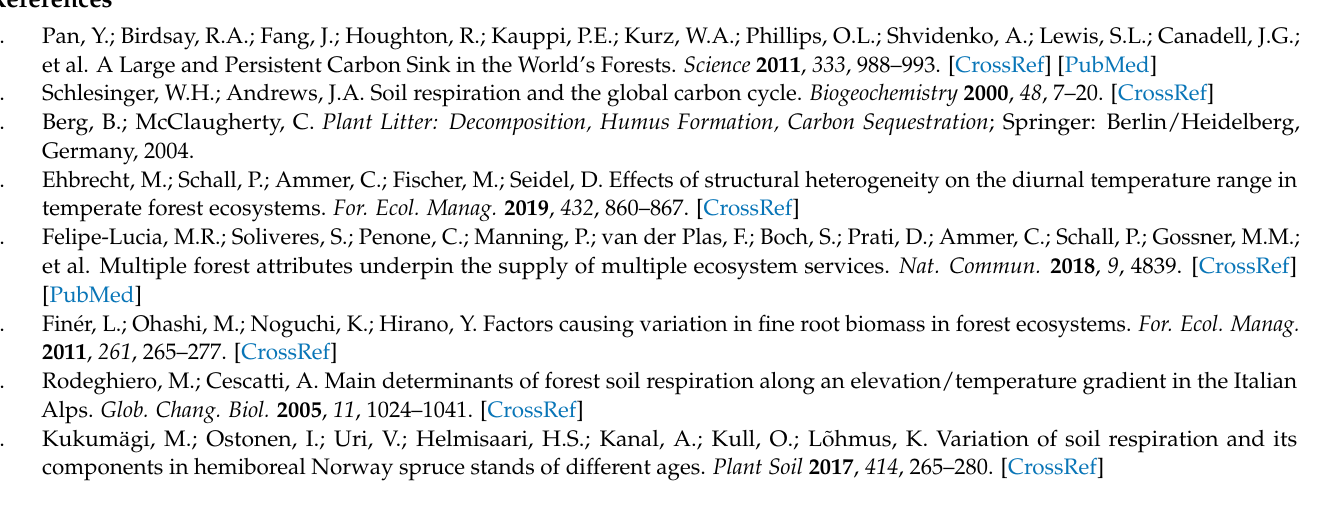
Figure S5: Soil volumetric water content (SVWC) during the soil respiration measurements over Water holding capacity (WHC) for the three study regions (i.e., Schwäbische-Alb: ALB, Hainich-Dün: HAI and Schorfheide-Chorin: SCH) and the two years (i.e., 2018 and 2019). Asterisks indicate differences between the two years for a given study site. Lower-case letters indicate differences between the tree study regions in 2018 and upper-case letters indicate differences between the tree study regions in 2019.; Figure S6: Correlation between total in-situ soil respiration and soil volumetric water content for the two sampling years (i.e., 2018 and 2019) and the three study regions (i.e., Schwäbische-Alb: ALB, Hainich-Dün: HAI and Schorfheide-Chorin: SCH). Equations and coefficient of determinations describe the linear relationship of total in-situ soil respiration and soil volumetric water content over all study